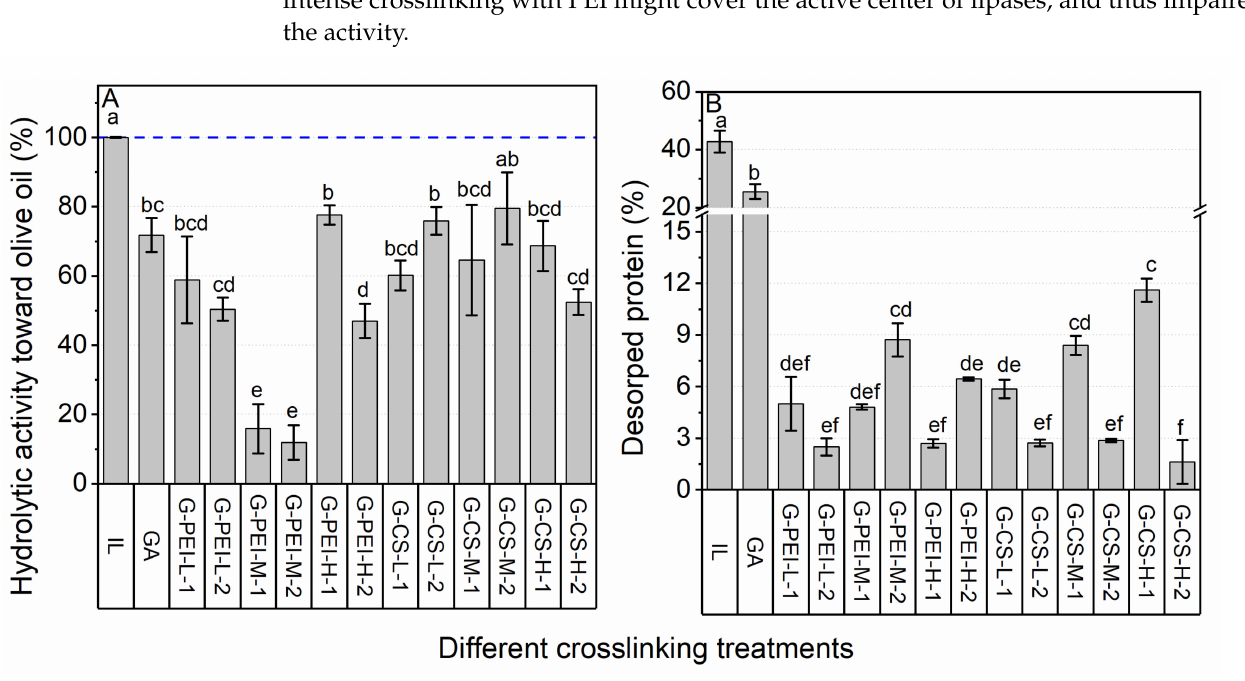
Figure 3. The effects of chemical crosslinking on hydrolytic activity ( A ) and stability against des- orption ( B ). Different lowercase letters indicate significant differences among different crosslinking treatments ( p < 0.05).